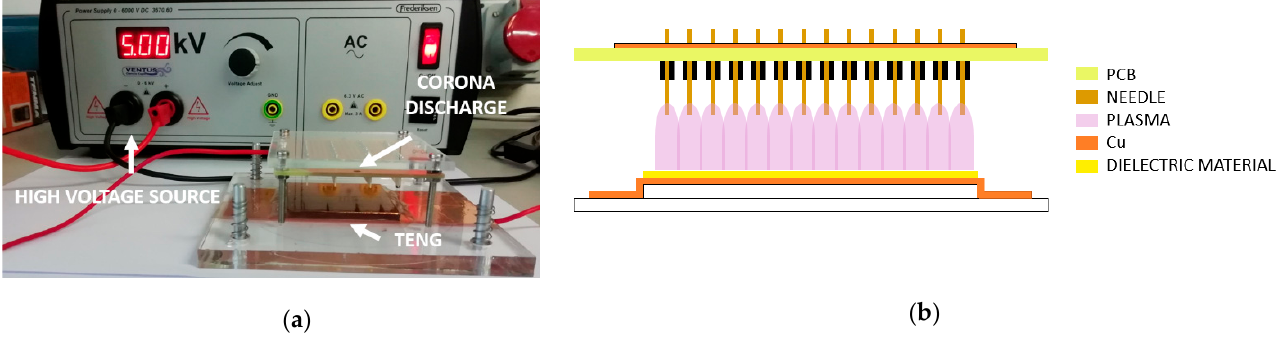
Figure 4. ( a ) Charge injection setup using high voltage corona charging; ( b ) schematic of the process of charge injection by corona.